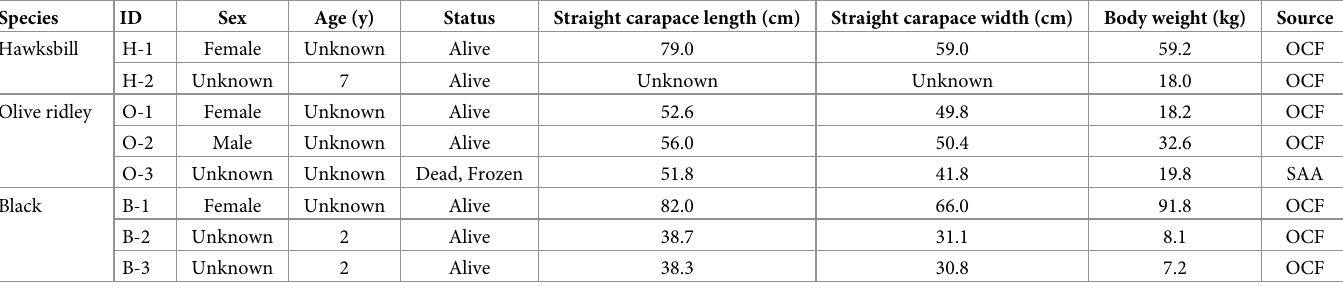
Table 1. Features of analyzed sea